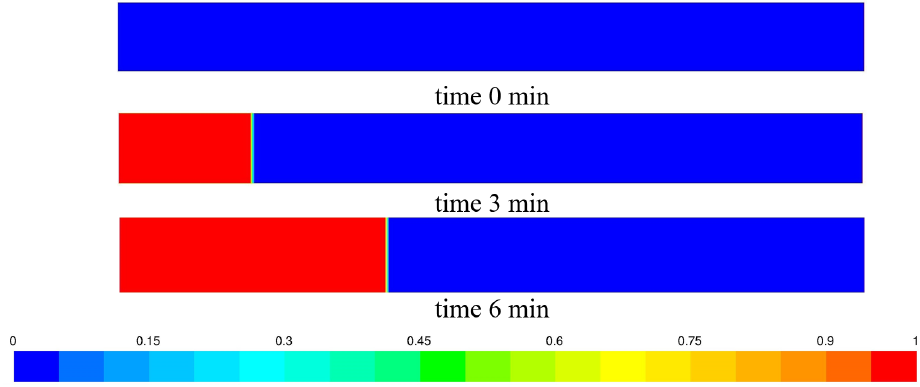
Figure 4. Temporal evolution of the concentration front in the continuous injection problem.